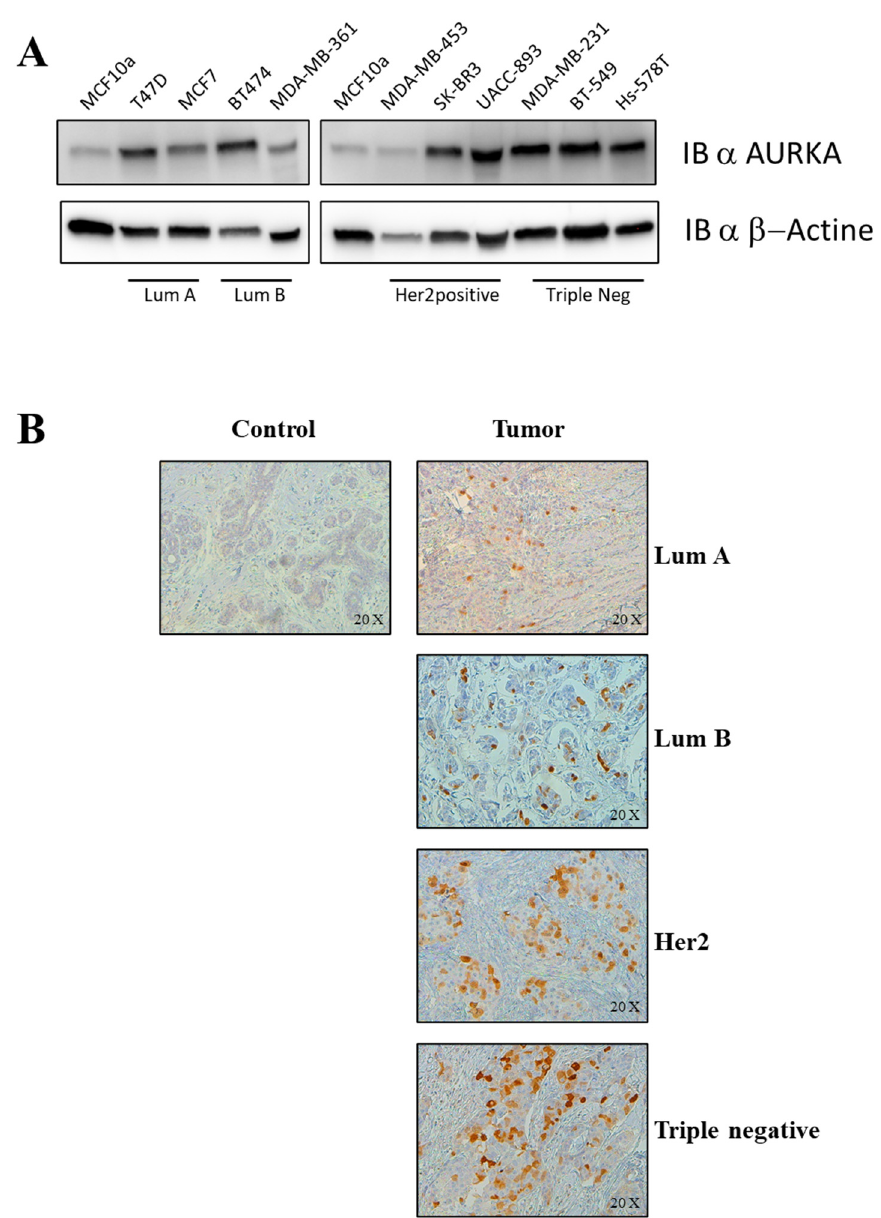
Figure 6. AURKA expression in vitro and ex vivo. ( A ) AURKA was examined by immunoblotting in T47D, MCF7 (Lum A), BT474, MDA-MB-361 (Lum B), MDA-MB-453, SK-BR3, UACC-893 (Her2), BT-549, Hs-578T (Triple Negative) and MCF10a (Control). B-actin served as a loading control. ( B ) Immunohistochemical analysis of AURKA was performed in surgical specimens of BC. The panel shows a control tissue with no AURKA-positive cells, and four tumoral tissues, one for each subtype (Lum A, Lum B, Her2, Triple-negative) with AURKA-positive cells. Magnification 20X. To evaluate its inhibition on cell viability, T47D, BT-474, SKBR3, and MDA-MB231 cell lines, each representing one BC subtype, were treated with alisertib. Cell viability assay indicated 0.5 µ M as the minimum dose of alisertib able to inhibit the cell growth of all cell lines up to three days of treatment (Figure 7A). We further evaluated the e ff ect of alisertib treatment on cell-cycle arrest. Compared to untreated (DMSO) cells, the percentage of all the indicated cell lines in G2 / M phase clearly increased in a time-dependent manner reaching the maximum cell-cycle arrest after 72 h of treatment (Figure 7B). Taken together these results indicated that the inhibition of AURKA slowed cell division similarly